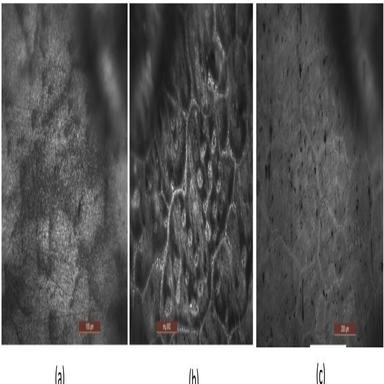
Optical microscopy of sample-Al + SiC (a) 1%, (b) 1.5% and (c) 2%.